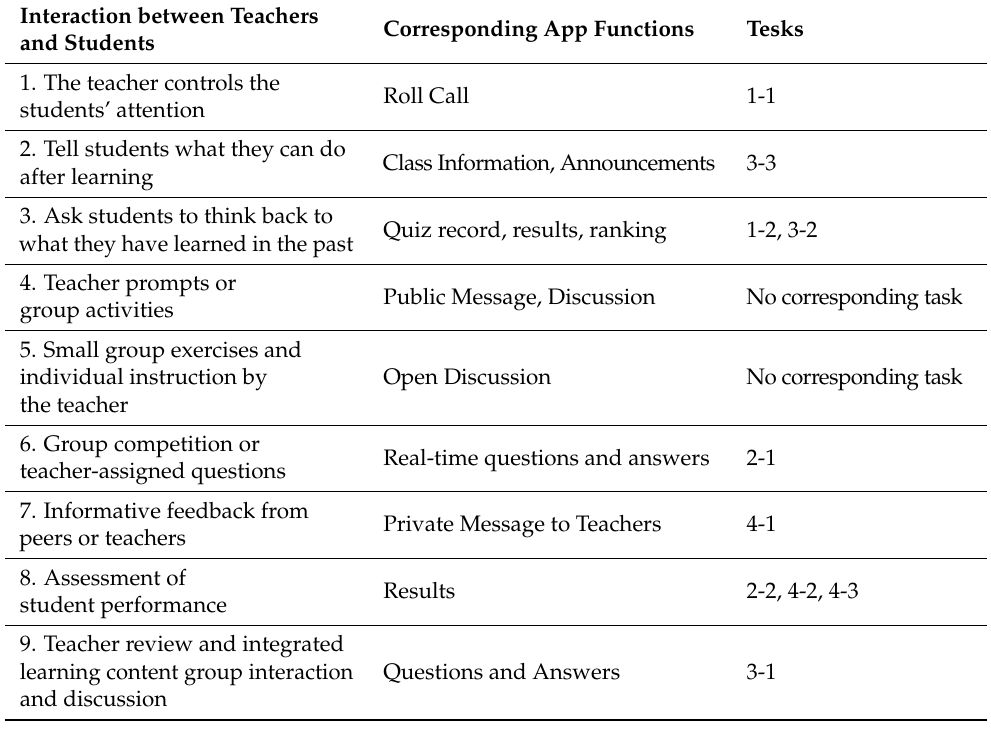
Table 4. Table of app functions corresponding to the teaching activities of the interactive response system.